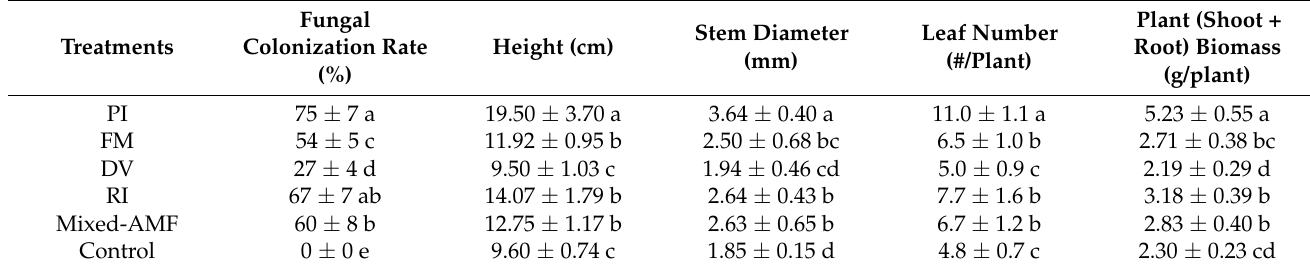
Table 2. Effects of symbiotic fungi on plant growth responses of Camellia oleifera plants.